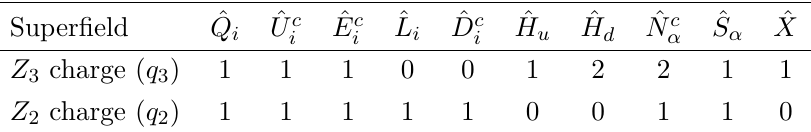
Table 1 . Super(cid:12)eld content of the model and charge assignment under the additional discrete Z 6 = Z 3 Z 2 symmetry. The new super(cid:12)elds compared to the MSSM, ^ N c , ^ S and ^ X , are singlets (cid:2) under the Standard Model gauge group. The indices i = 1, 2, 3 and (cid:11) = 1, 2 are generation indices. ( 1) 3( B (cid:0) L ) [23{26]. Here B stands for baryon number, L for lepton number, and s for (cid:0)